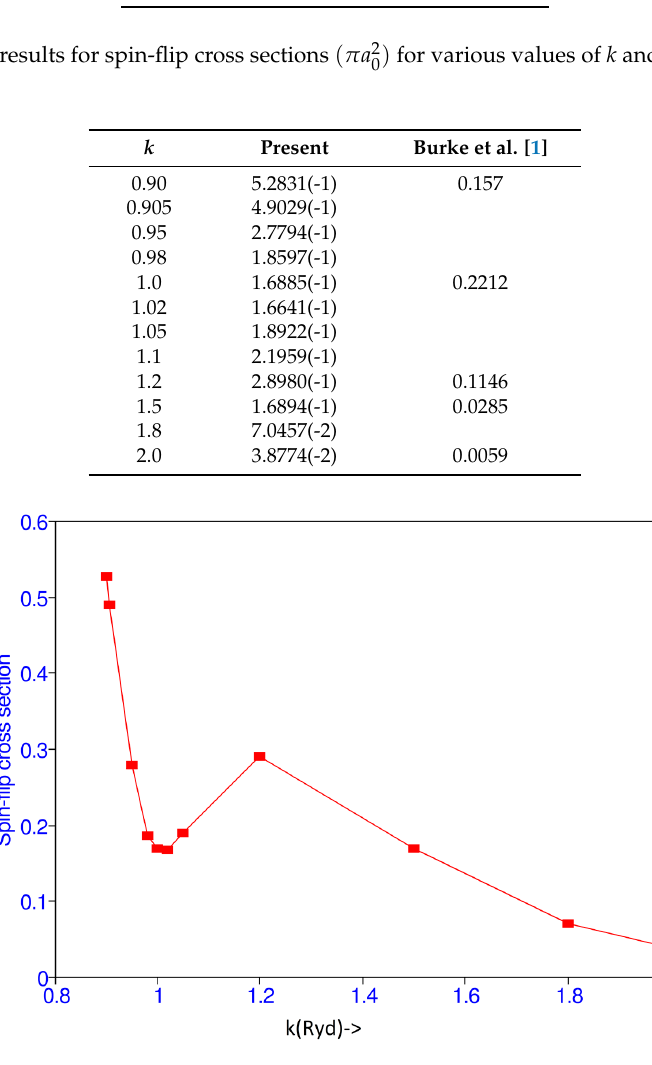
Figure 2. (Color online) Spin-flip cross section ( π a 2